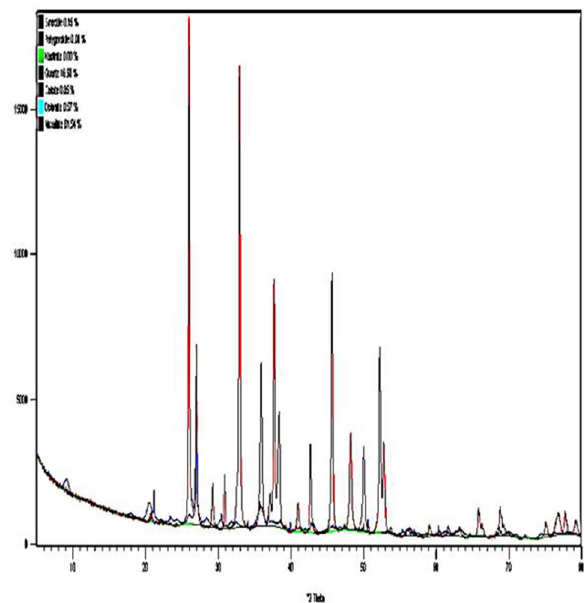
Fig. 7 X-ray diffraction pattern of OSA